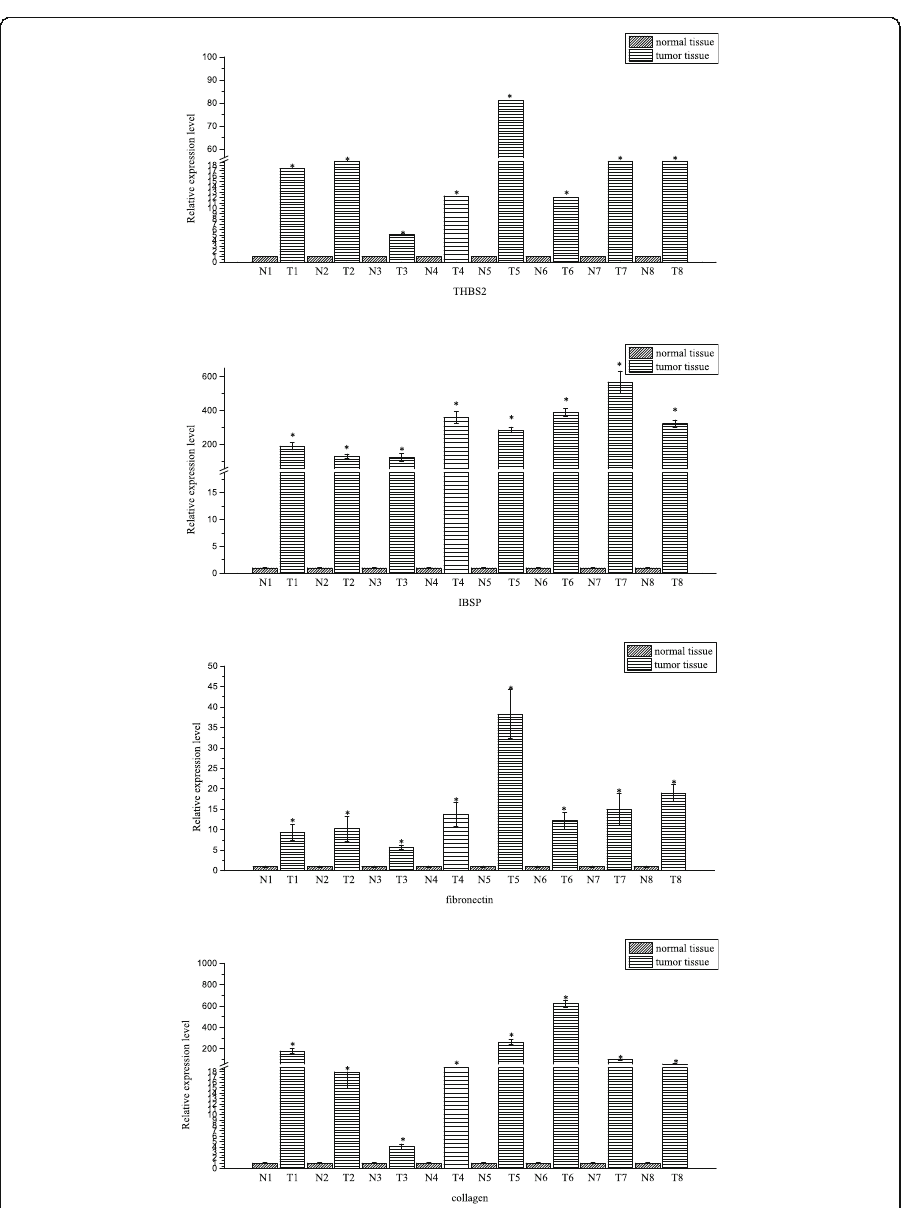
Fig. 4 The relative expressions of THBS2, IBSP, fibronectin and collagen in normal tissues and tumor tissues assessed via quantitative real time PCR. Fold changes are expressed as the ratio of gene expression in tumor tissue to that in normal tissue, normalized to 18S rRNA. The gene expression in normal tissue is normalized to 1. * p < 0.05, ** p < transcriptomes (37 in normal tissue and 0.3 in tumor tissue). Its low expression level may mean it is not a good cancer-related gene for breast tumors. CD300LG and BTNL9, which exhibited more than 32-fold downregulation in all the tumor transcriptomes, showed a very high differential expression patterns. The expression level of CD300LG (2343 RPKM) and BTNL9 (7326 RPKM) were very high in normal tissues but very low in the tumor transcriptome (56 RPKM and 283 RPKM, respectively). The same result was observed in the expression pattern of polymeric immunoglobulin receptor (PIGR), which demon- strated a negative 32-fold change (12,789 RPKM in normal tissues and 412 RPKM in